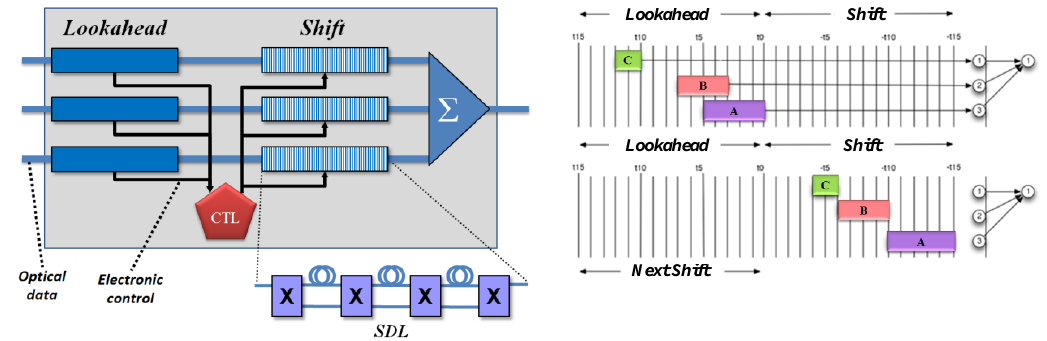
Figure 16. Our proposed packet merging architecture ( left ), composed of a lookahead region, a configurable switched delay line shift region, and a passive optical coupler. Packets in the lookahead region are batch scheduled with shifts in the shift region configured to avoid overlap ( right ).